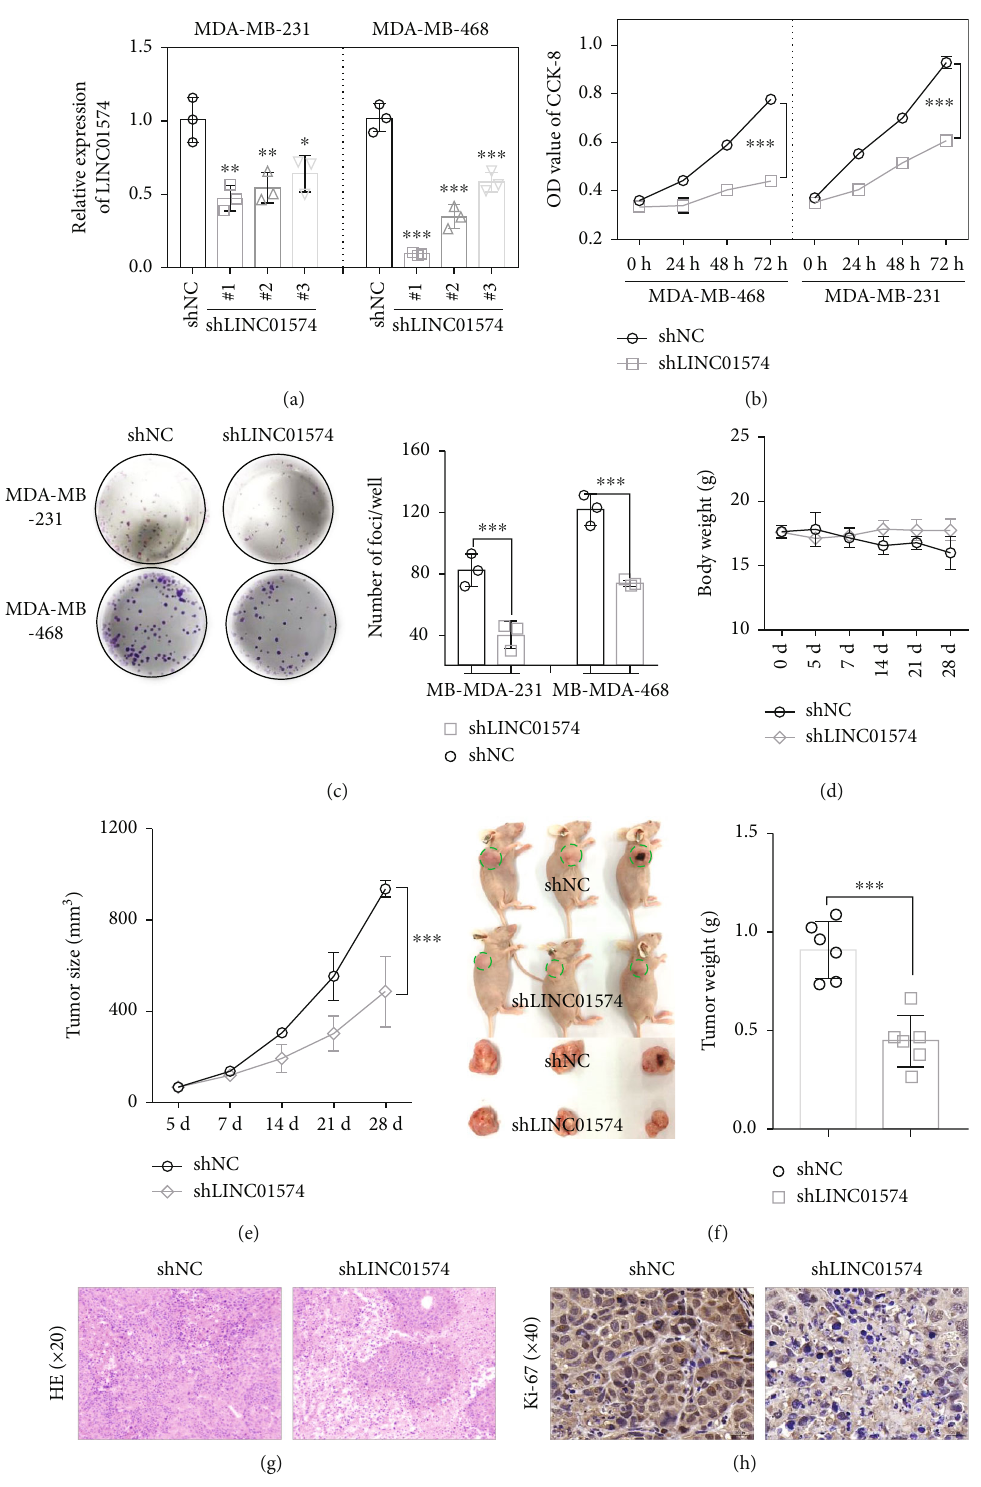
Figure 2: Knockdown of LINC01574 inhibited BC tumor growth in vitro and in vivo . (a) The mRNA levels of LINC01574 after transfection were tested by qRT-PCR. (b, c) The e ff ects of shLINC01574 on the proliferation of BC cells were examined. (d, e) In the tumorigenesis model, the body weight and tumor size were detected. (f) Tumor volume and weight in the shNC group and shLINC01574 group were assessment. (g, h) H&E and Ki-67 staining in the tumor. ∗ P < 0 : 05 , ∗∗ P < 0 : 01 , and ∗∗∗ P < 0 : 001